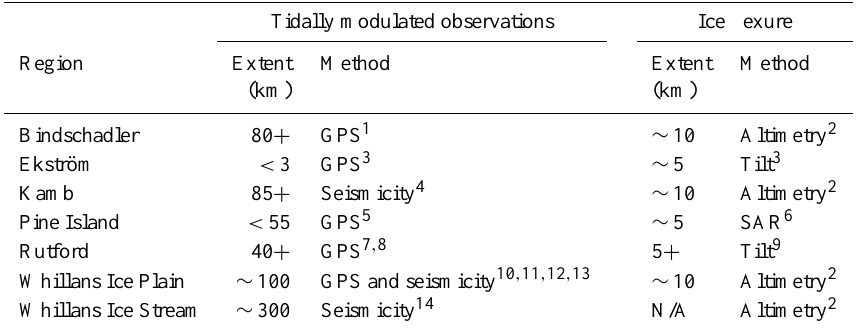
Table 1. Spatial extent of observations suggesting tidal modulation of ice stream motion and ice flexure from selected ice streams across Antarctica. Tidally modulated observations